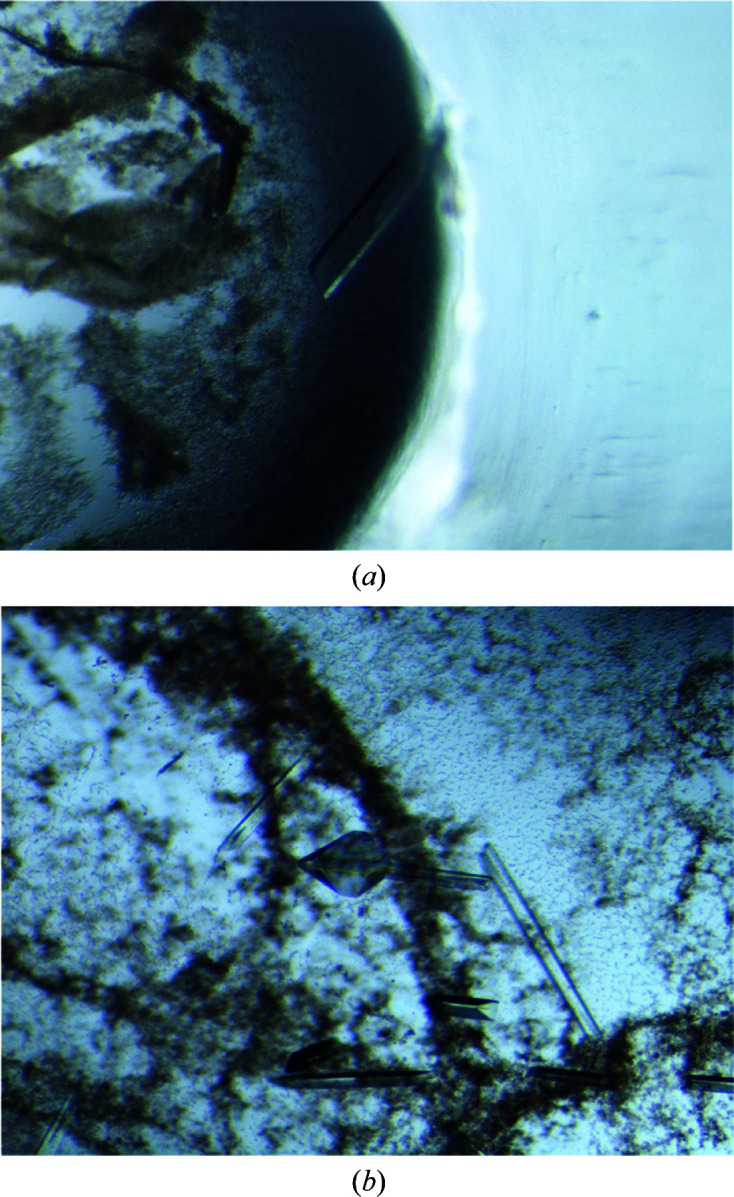
Crystals of ADH from E. coli. (a) Orthorhombic space group P212121, (b) tetragonal space group P432121.